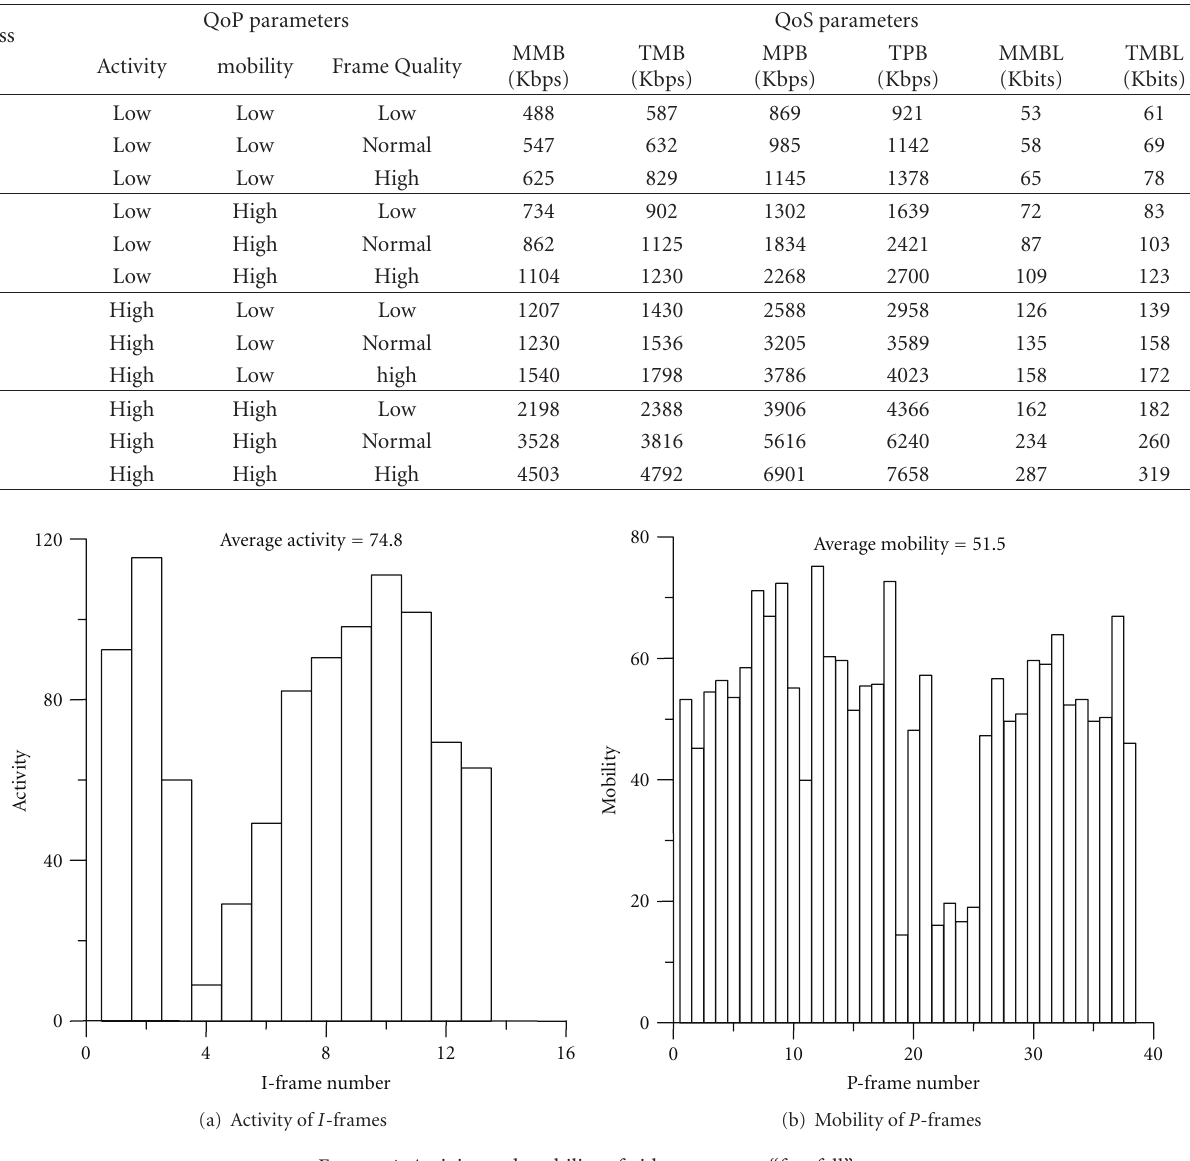
Figure 4: Activity and mobility of video sequence